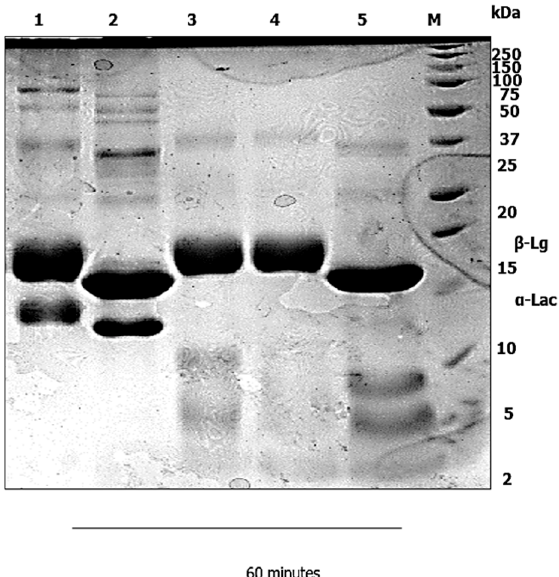
Figure 2. In vitro infant digestion using a static model of WPI-lac. α -Lac in Lane 2 was completely hydrolyzed with pepsin after 5 min of digestion (Lane 3). The SDS–PAGE again showed that the β -Lg was resistant to pepsin in gastric digestion. Lane 1: WPI–Lac without pepsin; Lane 2: 0 min; Lane 3: 5 min; Lane 4: 30 min; and Lane 5: 60 min. Lane M represents a protein